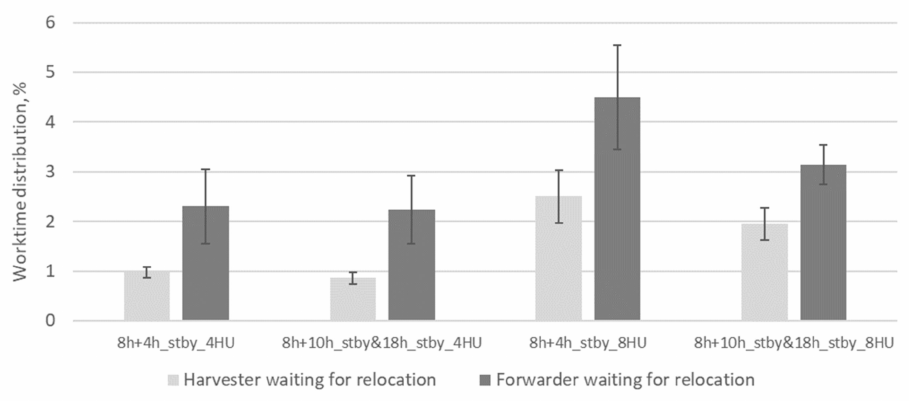
Figure 13. Impact of the relocation options in terms of the readiness time for relocations per working day. The 8h+4h-stby consisted of an 8 h work shift of a relocation truck driver added to 4 h of standby mode managed by the head personnel of the harvesting entrepreneur. The 8h+10h-stby and 18h-stby consisted of 18 h readiness for relocations per